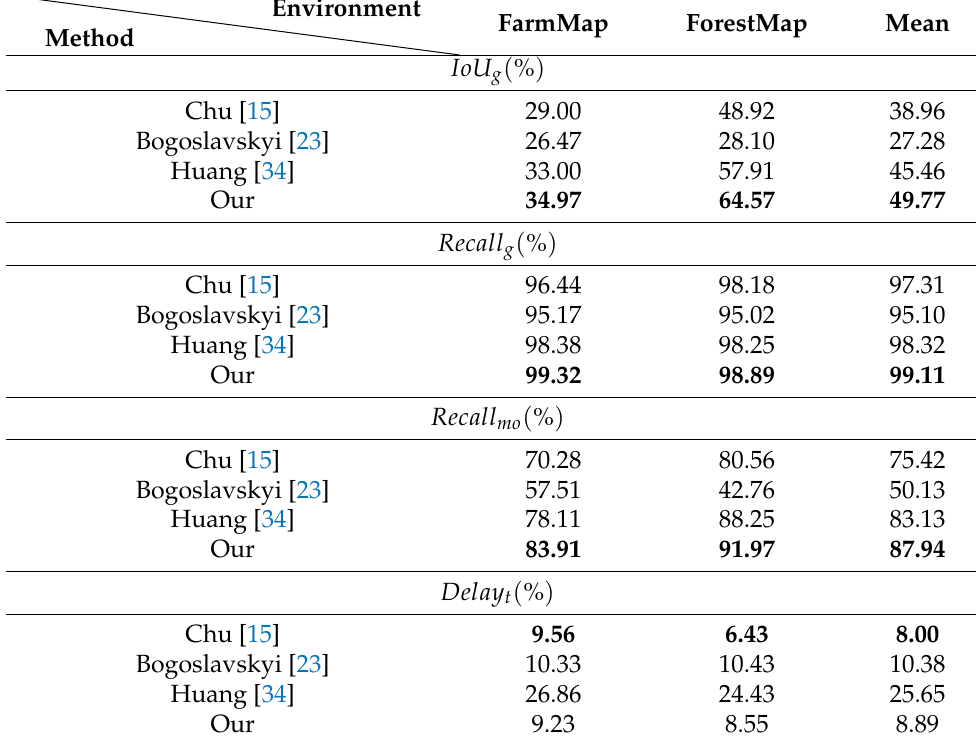
Table 3. The evaluation results on the Koblenz dataset.